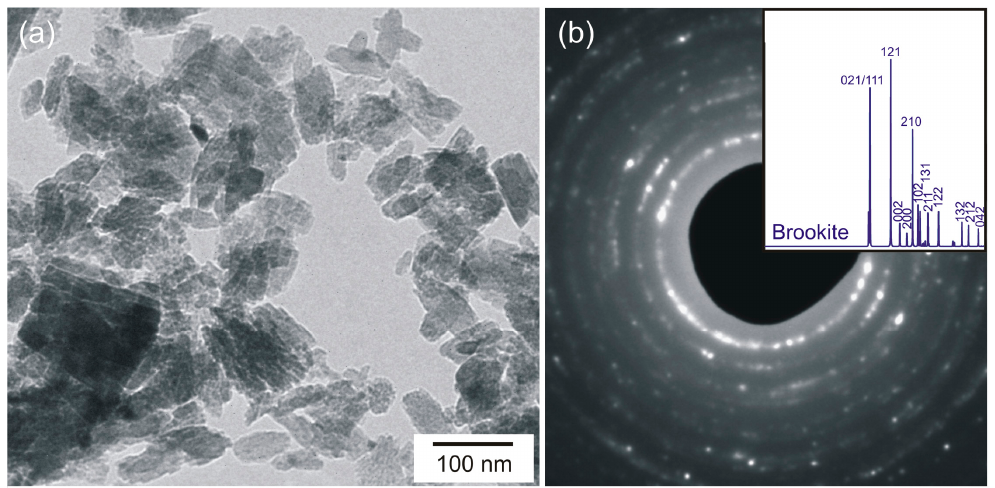
Figure 4. ( a ) Bright field TEM image of the TiO 2 structure detected at the 80 °C H 2 O nanorod spheres; ( b ) Ring diffraction pattern confirming the TiO 2 brookite phase (TiO 2 brookite simulation is included).